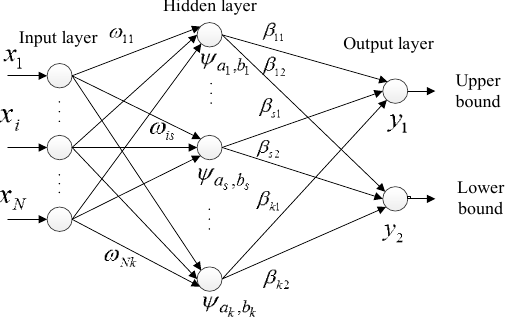
Figure 1. WNN-based on the PI construction model. WNN: wavelet neural network; PI: prediction interval.